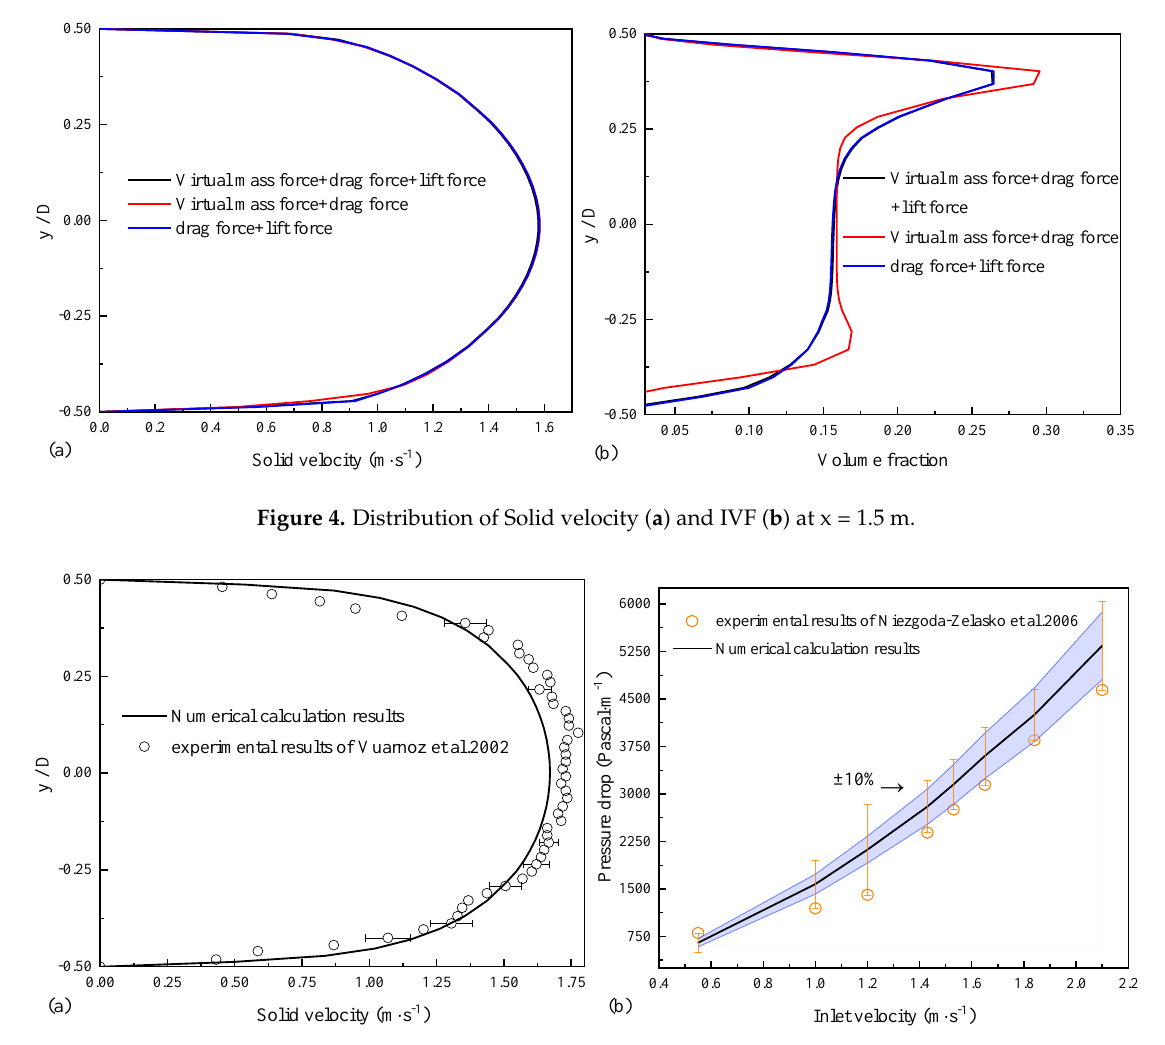
Figure 4. Distribution of Solid velocity ( a ) and IVF ( b ) at x = 1.5 m.